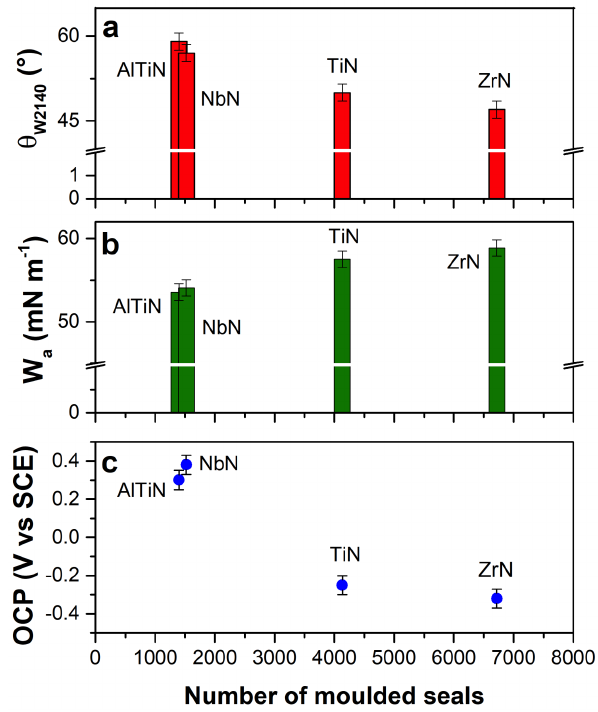
Figure 3. Correlations between ( a ) Marbocote ® W2140 contact angles on uncleaned PVD coatings, ( b ) relative work of adhesion (W a ), ( c ) Open circuit potential (OCP) and number of molded seals. Coatings 2020 , 10 , x FOR PEER REVIEW